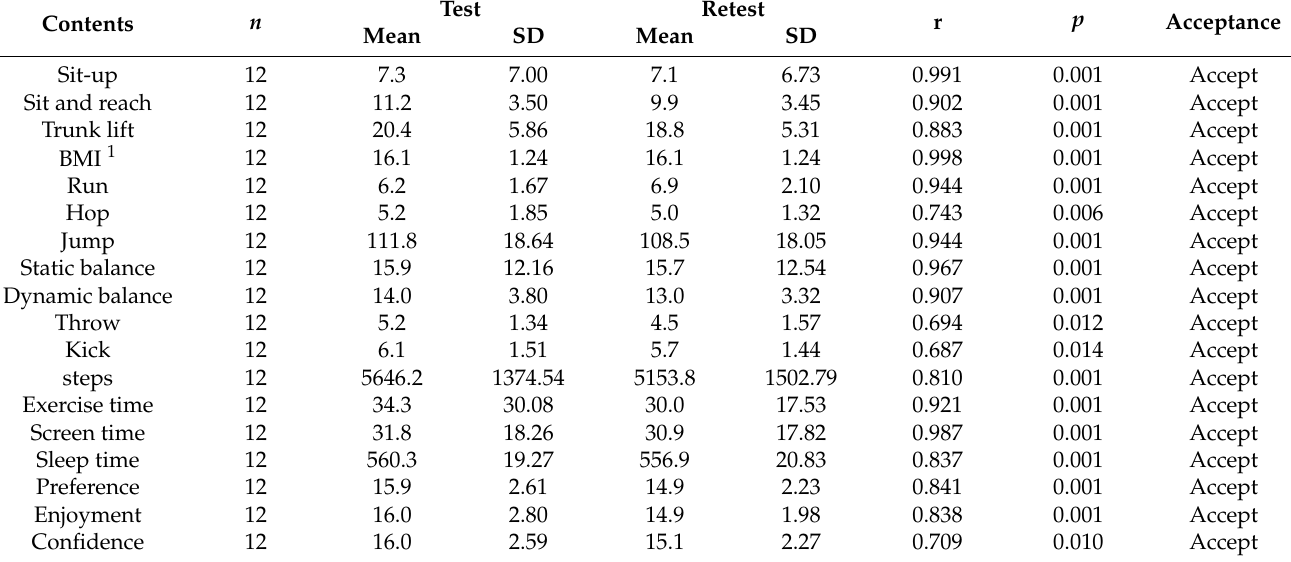
Table 4. Reliability analysis results of children physical activity competency test